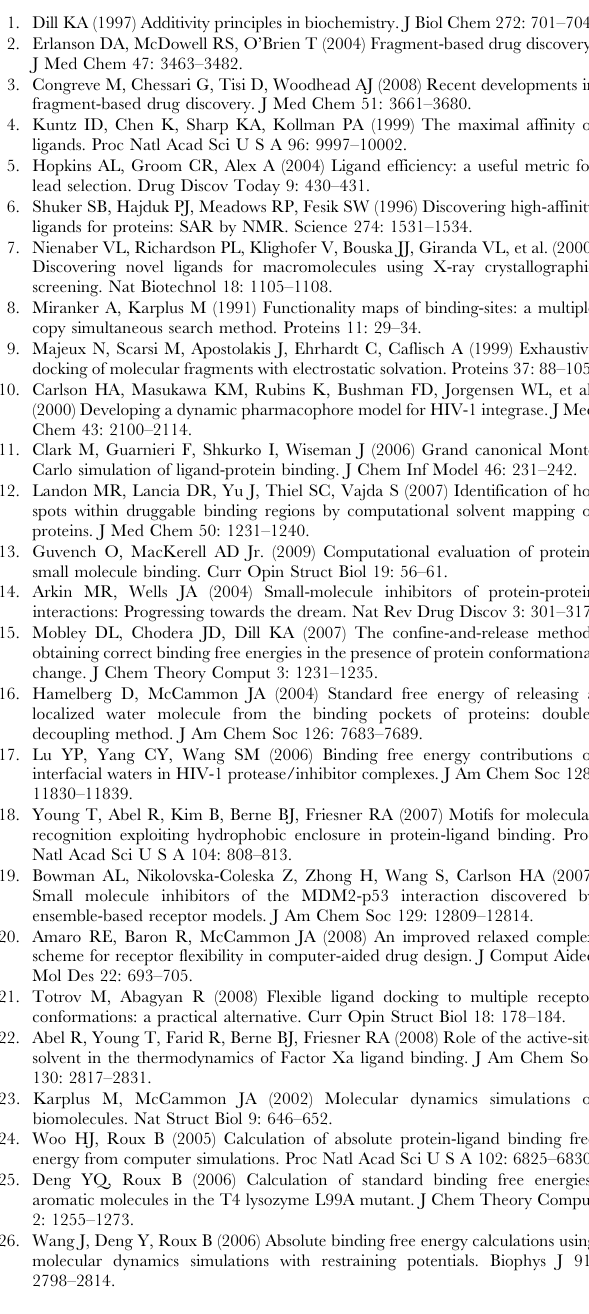
BCL-6 molecular surface taken perpendicular to the two-fold symmetry axis of the protein. A through D are the same slices as in Figure 2. E is an additional successive slice. Found at: doi:10.1371/journal.pcbi.1000435.s002 (1.49 MB TIF) Figure S3 Successive slices of the hydrogen bond acceptor FragMap, generated by mapping water oxygen atoms, and the BCL-6 molecular surface taken perpendicular to the two-fold symmetry axis of the protein. A through D are the same slices as in Figure 2. E is an additional successive slice. Found at: doi:10.1371/journal.pcbi.1000435.s003 (1.52 MB TIF) Figure S4 Arg24 sidechain (A) x 1, (B) x 2, (C) x 3, and (D) x 4 dihedral distributions from the SILCS MD simulations.